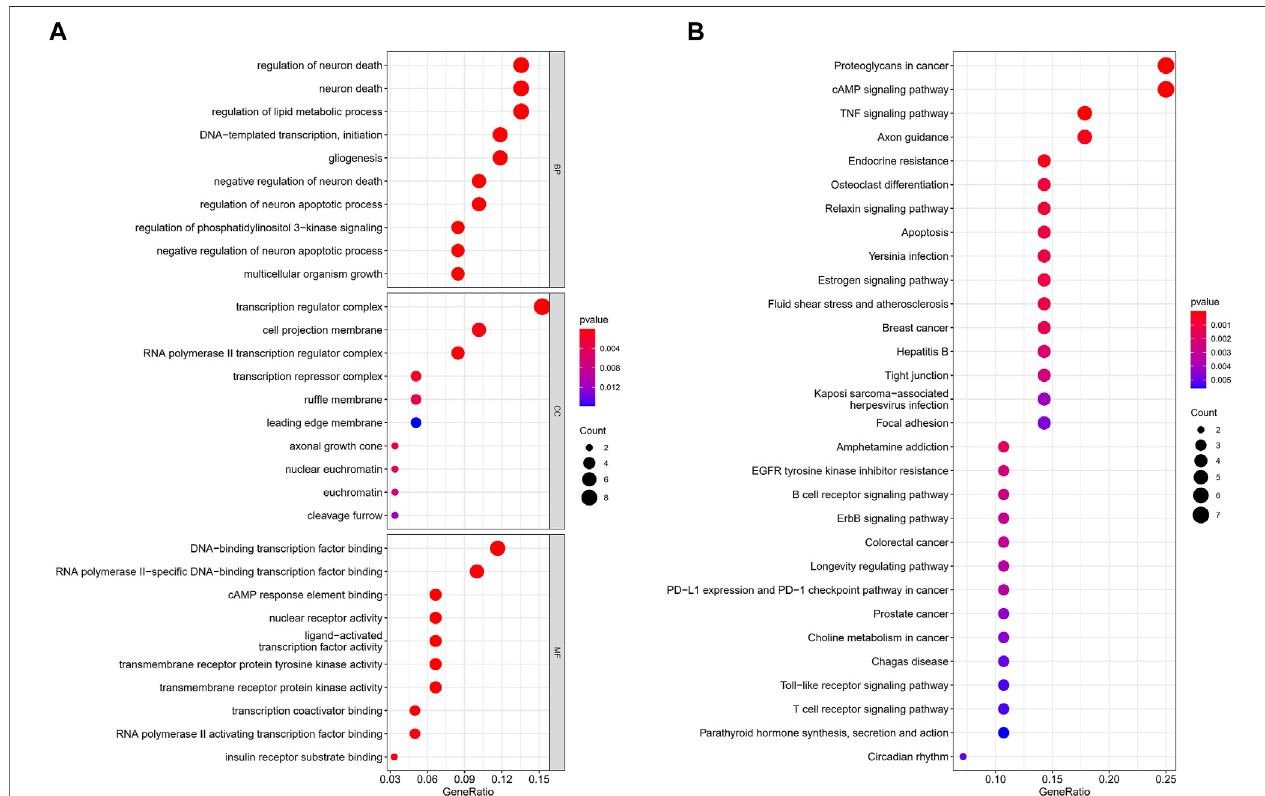
FIGURE 6 | GO and KEGG enrichment analysis. (A) GO analysis. (B) KEGG